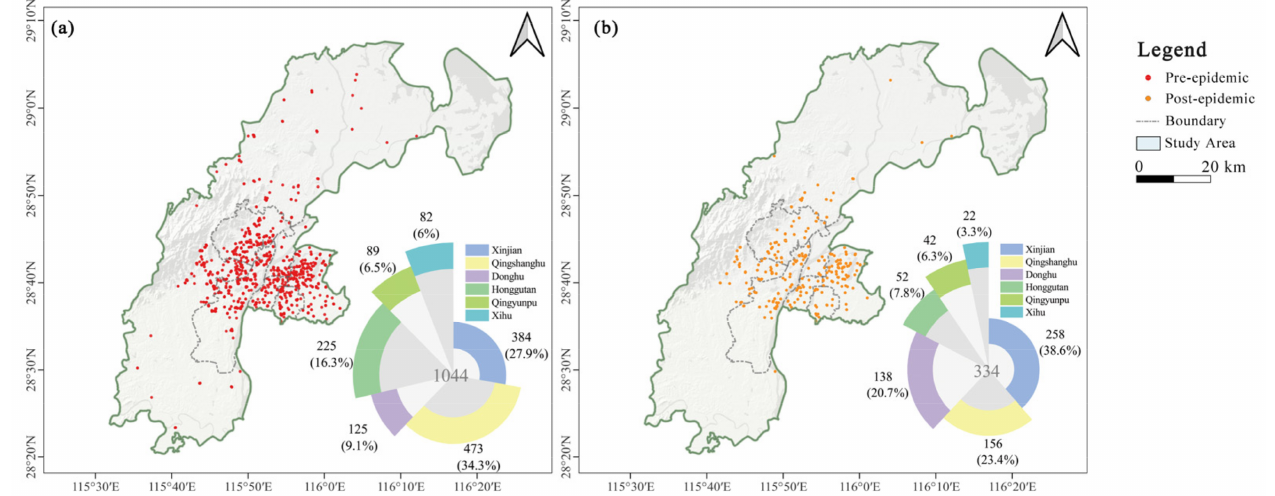
Figure 4. The open outdoor sports venues in Nanchang: ( a ) pre-epidemic; ( b )